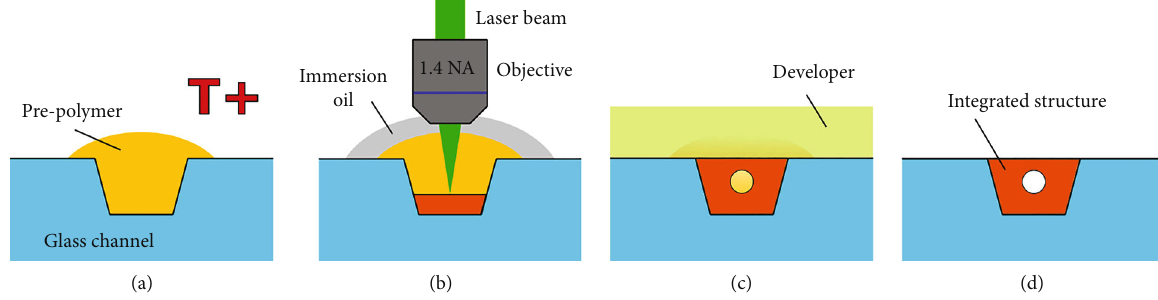
Figure 2: Steps of integrating the polymeric structure into an open glass channel using the hard prepolymer (in our case SZ2080) and immersion objective. (a) Prebake of the material. (b) Integration of functional element into the channel by applying immersion oil onto hard prepolymer. (c) Development. (d) Finished structure.